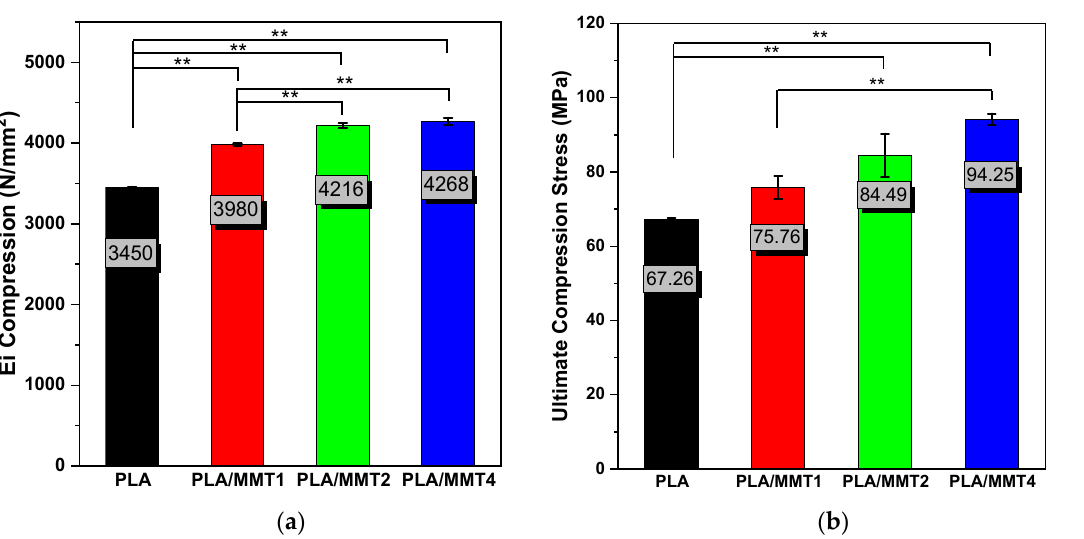
Figure 10. Effect of MMT content on the ( a ) E i Compression Modulus and ( b ) Ultimate Compression Stress of PLA/MMT 3D-printed specimens. ** p ≤